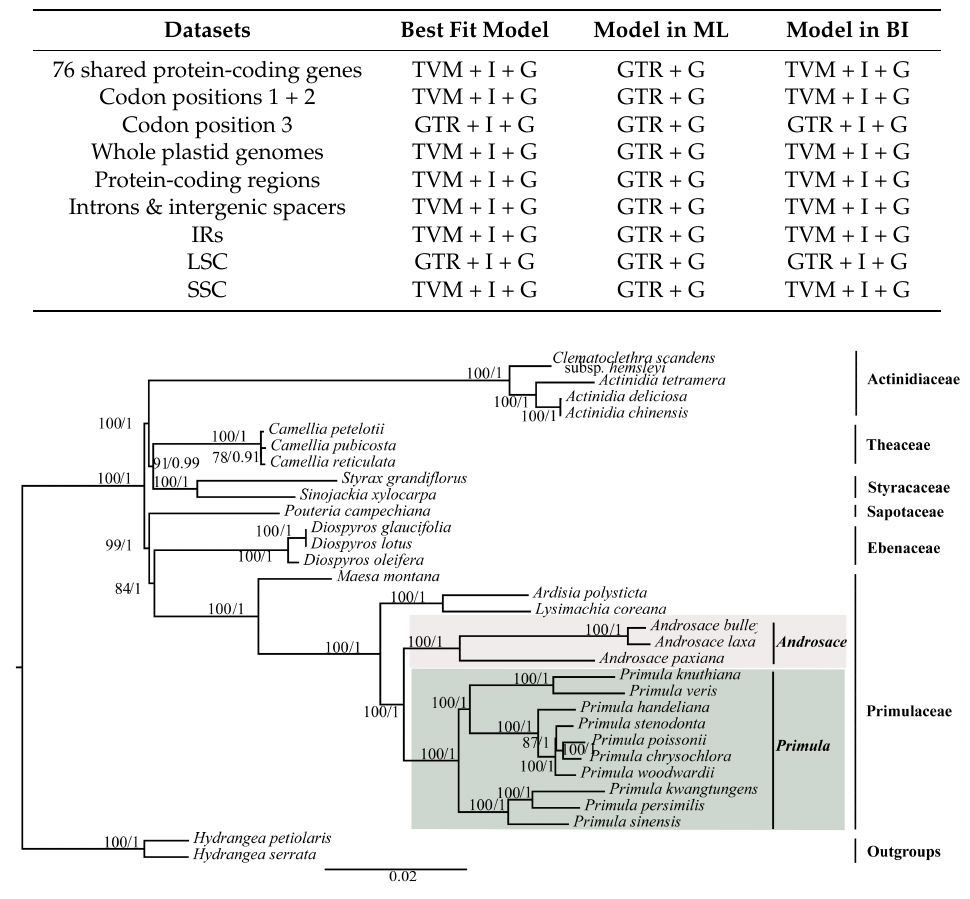
Figure 5. Phylogenetic relationship of the 31 species inferred from ML and BI analyses based on 76·shared protein-coding genes. The numbers near each node are bootstrap support values and posterior probability. Hydrangea petiolaris and Hydrangea serrata were used as the